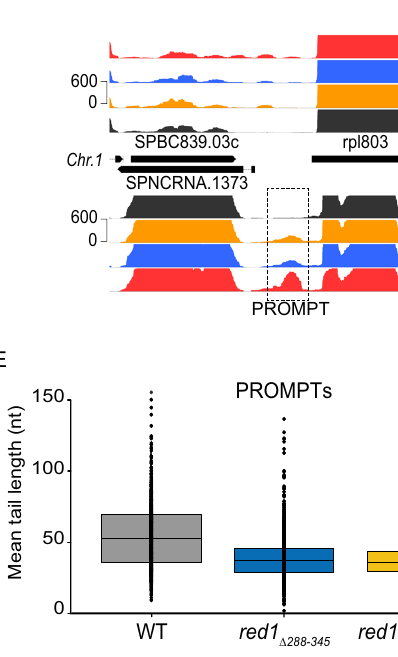
genes in WT and mutant strains. Dashed boxes highlight two representative examples of CUTs: antisense RNA transcripts (AS) on the left panel and PROMPTs ontherightpanel. D , E Box-plotofmeanpoly(A)taillengthdistributionofMTREC- associated mRNAs ( D ) and PROMPTs ( E ) for the WT and indicated mutant strains (5135 mRNAs and 619 PROMPTs with FC>2 are shown). Dots represent the mean poly(A)taillengthofindividualmRNAs/PROMPTs,boxesshowthe25 – 75percentile range and the horizontal lines represent the median values. Upper and lower whiskers represent 75th percentile plus 1.5 times the inter-quartile distance (IQR) and he 25th percentile minus 1.5IQR, respectively. Source data are provided in Source Data fi